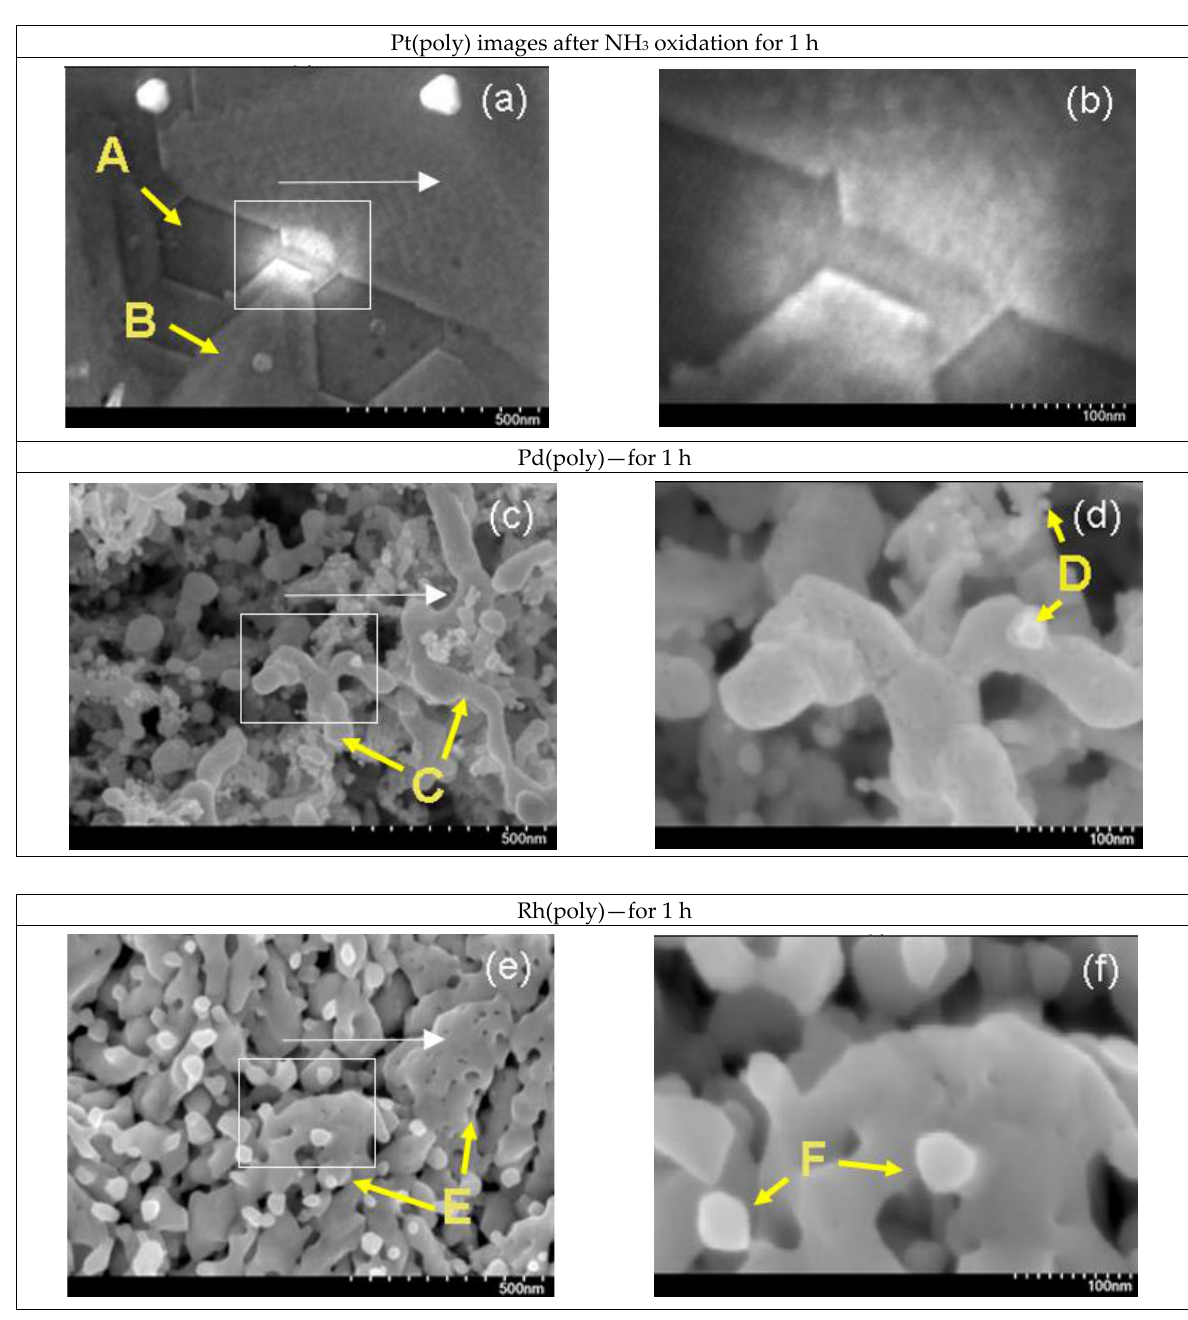
Figure 9. SEM images of the Pt(poly) ( a , b ), Pd(poly) ( c , d ) and Rh(poly) ( e , f ) surface after NH 3 oxidation with air at T = 1133 K for 1 h. Images were obtained in SE mode at E 0 = 5 keV and × 100 k ( a , c , e ), × 300 k ( b , d , f ) magnifications. A–F and arrows indicate the objects discussed in the text. Rectangles indicate the regions represented by images with a higher